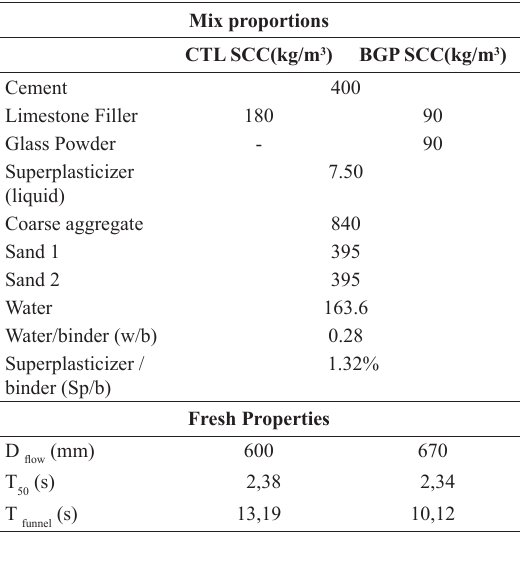
Table 3. Mix proportions of SCC’s and fresh properties.